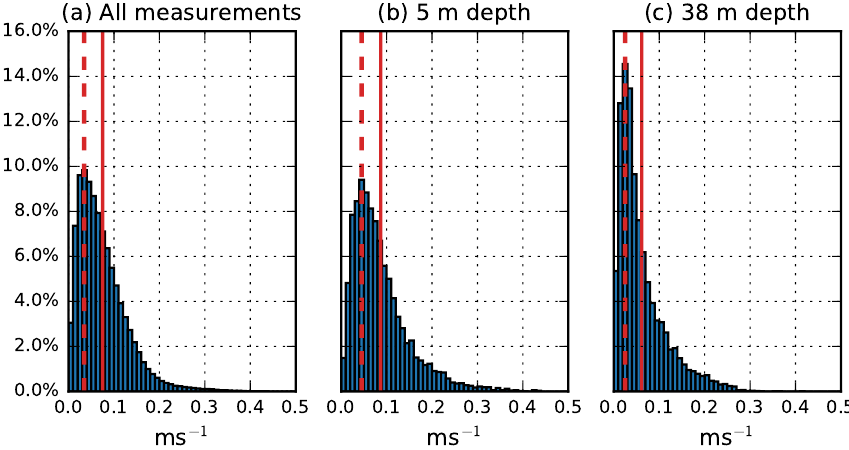
Figure 2. Current speed distribution over the whole water column ( a ), at the upper-most measured depth ( b ) and at the bottom-most measured depth ( c ). Solid red line represents arithmetic mean and dashed red line mode of the